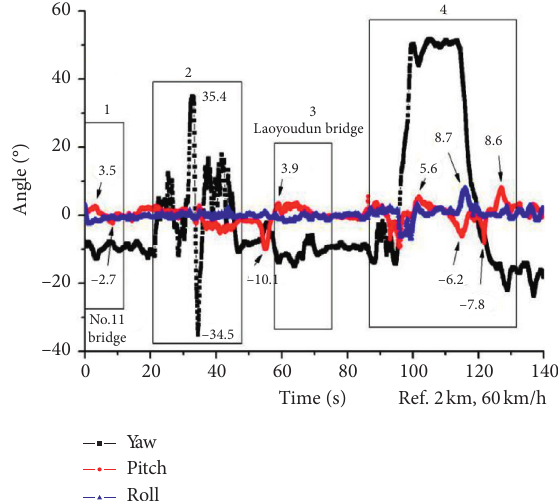
Figure 8: The running posture of the vehicle.